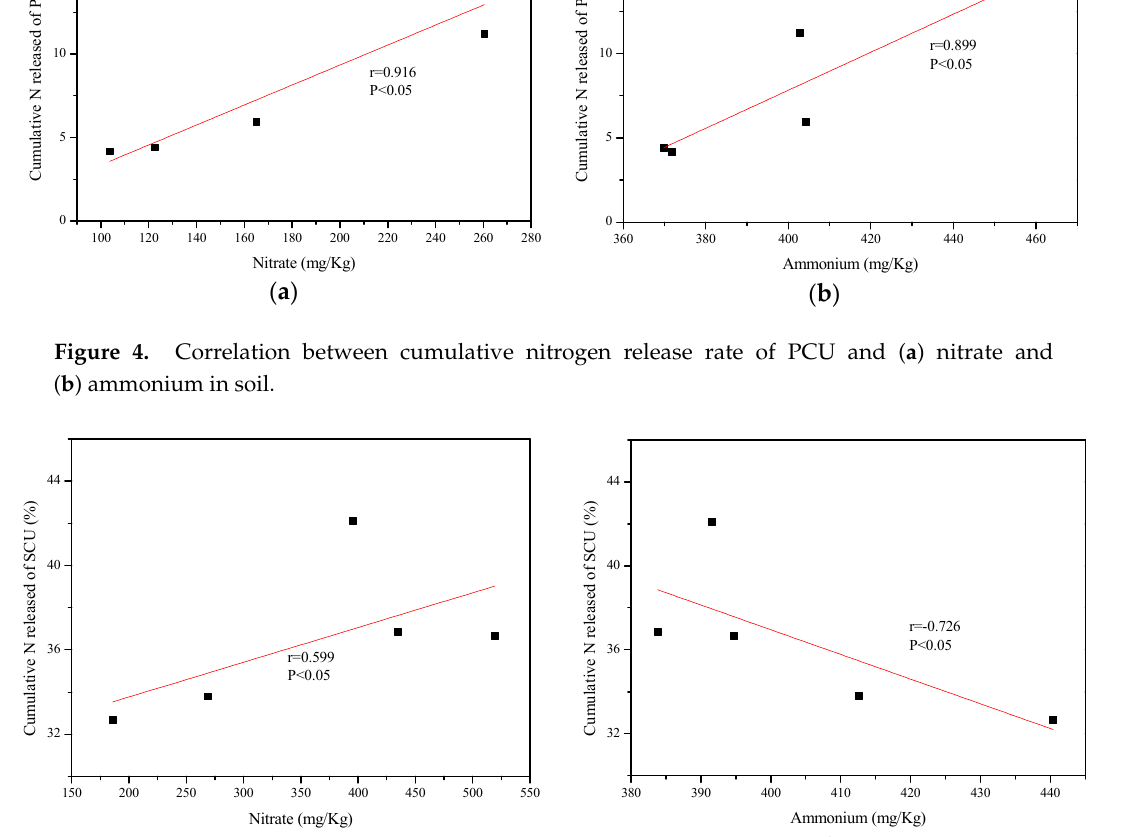
Figure 5. Correlation between cumulative nitrogen release rate of SCU and ( a ) nitrate and ( b ) ammonium in soil.